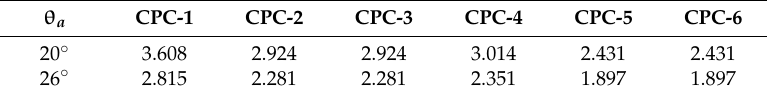
Table 1. Geometric concentration factors of full compound parabolic solar concentrators.